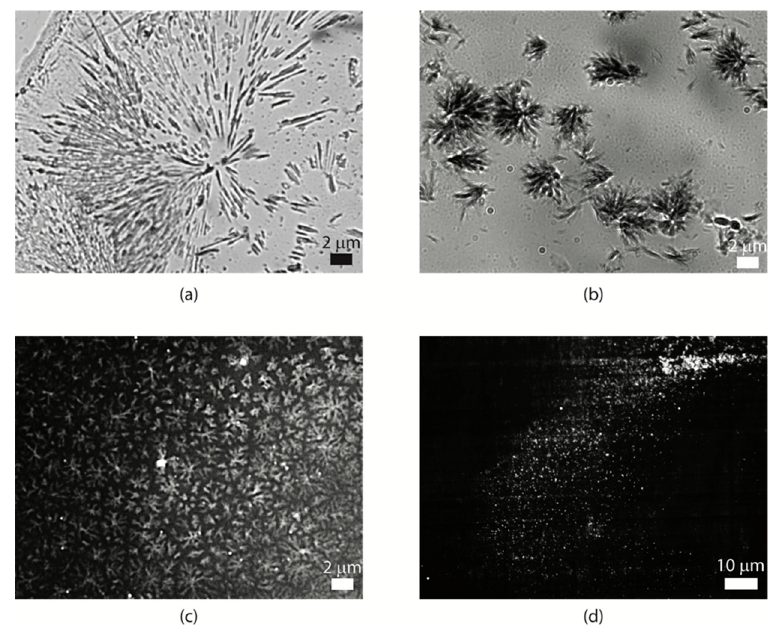
Figure 5. Microscope transmission images of drop casted equilibrium solution on glass of ( a ) ( D )ZnP(-)@( R )-1-phenylethanamine solution; ( b ) freshly drop casted equilibrium solution with wet precipitate (see text). Fluorescence emission image of drop casted equilibrium solution of ( c ) ZnpCTPP(-)@( R )-1-phenylethanamine, and ( d ) ZnpCTPP(-) aggregates.